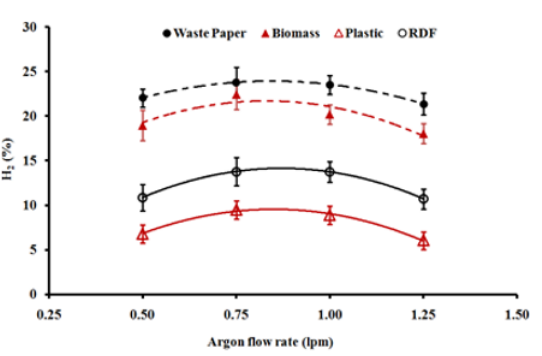
Figure 2. The variation in the H2 evolution with the carrier gas flow rate and the type of